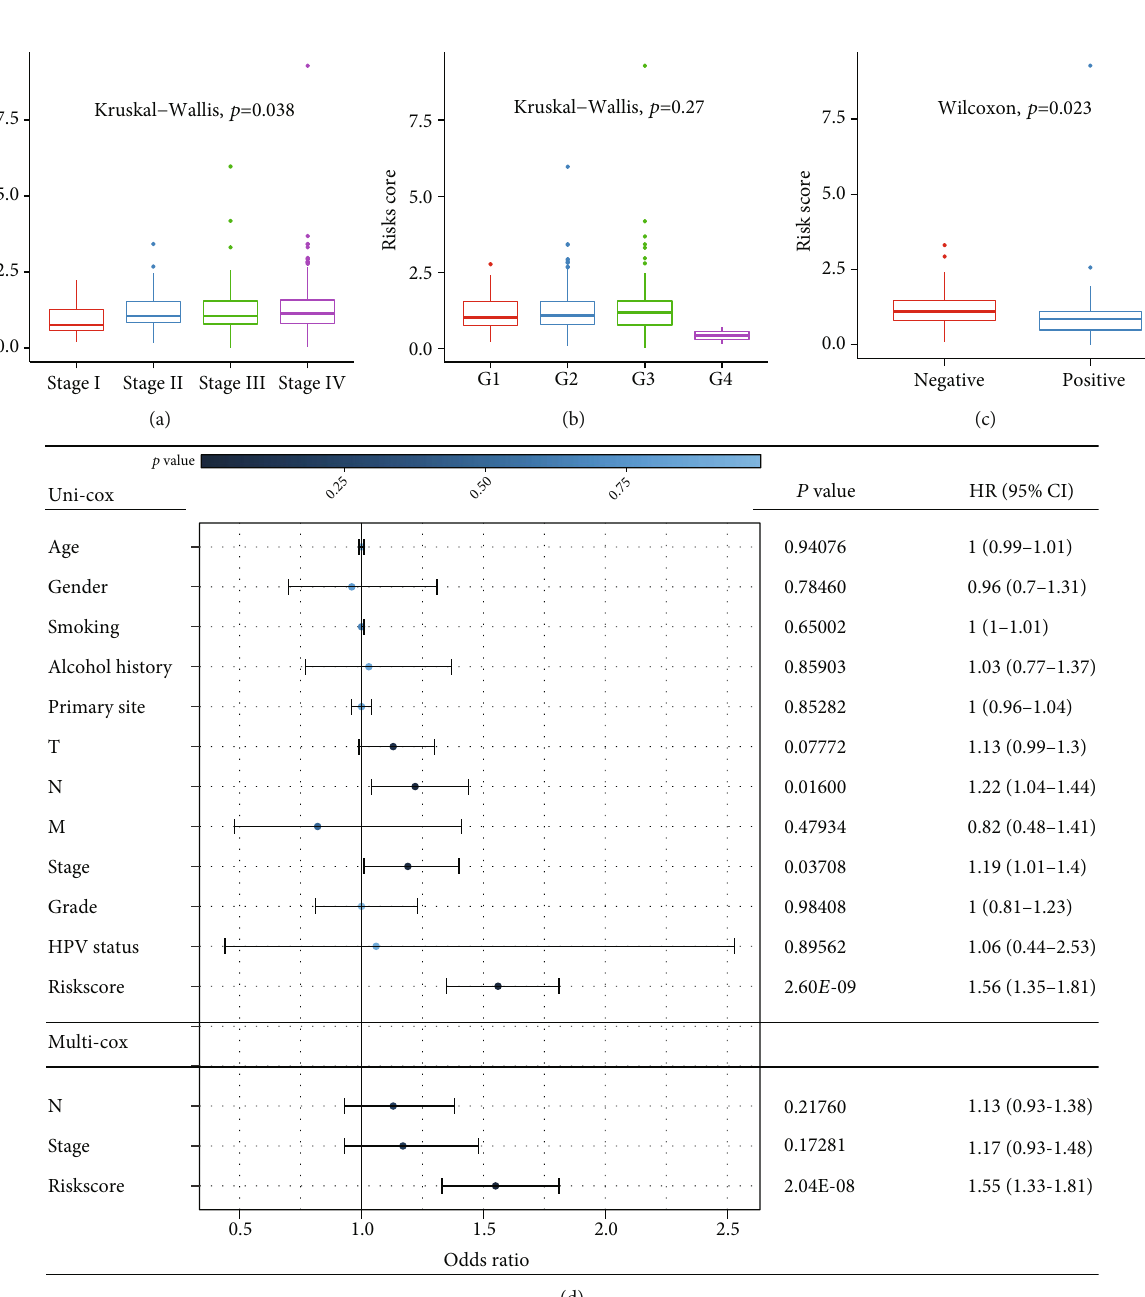
Figure 4: Coanalysis with clinical traits. (a-c) Risk score in di ff erent groups of clinical stages, pathological grades, and HPV status. (d) Forest plot of risk score and clinical traits. HR: hazard ratio; CI: con fi dence interval. A univariate Cox hazard ratio analysis demonstrated that N stage ( p < 0 : 05 , HR = 1 : 22 , 95% CI [1.04 – 1.44]), clinical stage ( p < 0 : 05 , HR = 1 : 19 , 95% CI [1.01 – 1.40]), and risk score ( p < 0 : 0001 , HR = 1 : 56 , 95% CI [1.35 – 1.81]) were statistically di ff erent. Only risk score ( p < 0 : 0001 , HR = 1 : 55 , 95% CI [1.33 – 1.81]) presented as an independent prognostic predictor by multivariate Cox